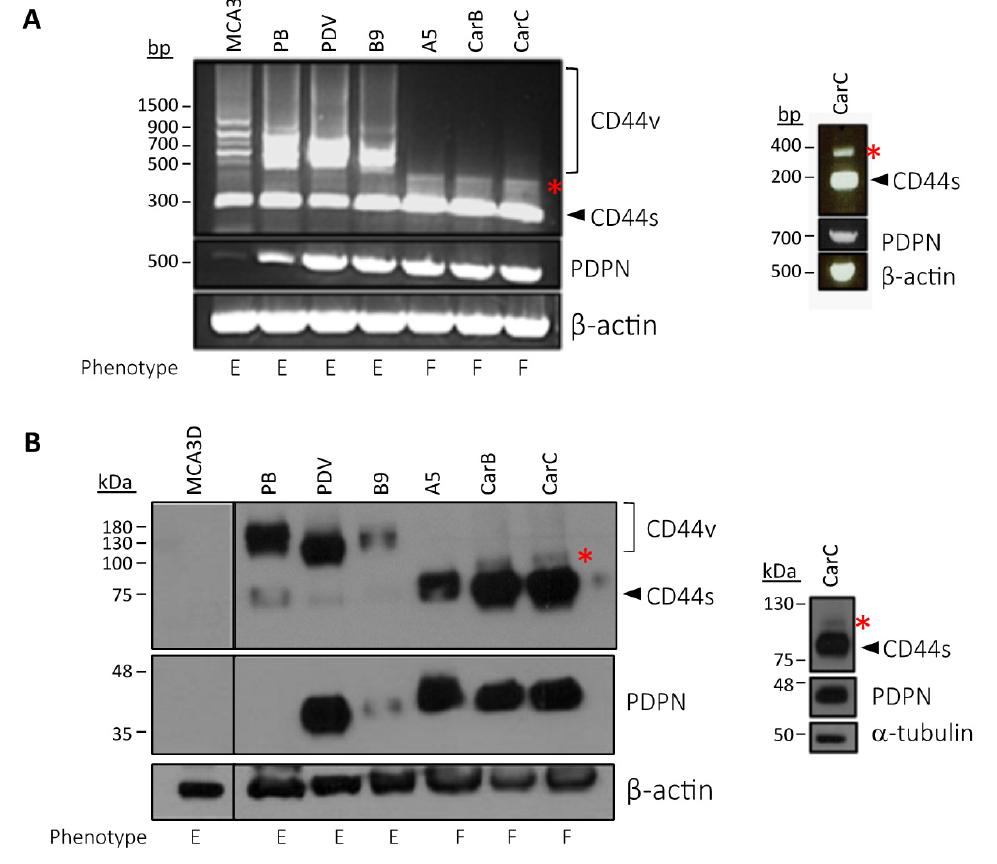
Figure 3. Podoplanin is co-expressed with CD44v and CD44s in transformed mouse epidermal cell lines. CD44v10 is specifically expressed in spindle carcinoma cells. ( A ) RT–PCR analysis of podoplanin and CD44 mRNA expression in the cell lines. The asterisk indicates a transcript of ~380 bp specifically expressed in differentiated spindle cell carcinomas (SpCCs) cells that after isolation (right panel) and sequencing was identified as CD44v10. β -actin was used as a control of RNA loading; ( B ) Western-blot analysis of podoplanin and CD44 protein expression in the cell lines. Asterisk indicates a protein band putatively corresponding to CD44v10. β -actin and α -tubulin (blot on the right) were used as controls of protein loading. Letters below the blots indicate the phenotypes of the cell lines: E—epithelial; F—fibroblastic. Results represent three independent experiments.